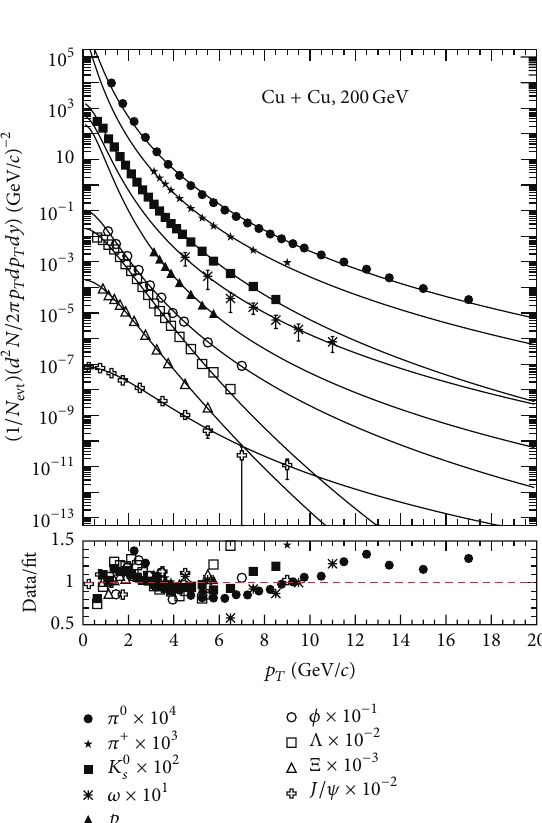
Figure 4: The data are from [11, 31, 40, 45–47] for Cu + Cu at = 200 GeV. The curves are the analytical results with Tsallis √𝑠 𝑁𝑁 distribution Equation (10). The corresponding fitting parameters and 𝜒 2 /ndf are given in Table 1. For a better visualization both the data and the analytical curves have been scaled by a constant as indicated. The ratios of data/fit are shown at the bottom.